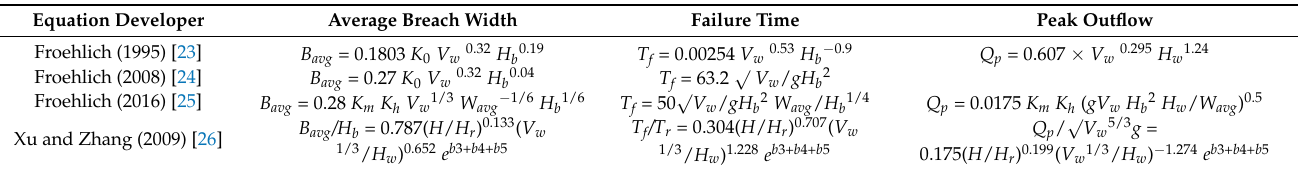
Table 2. Empirical equations of Froehlich and Xu and